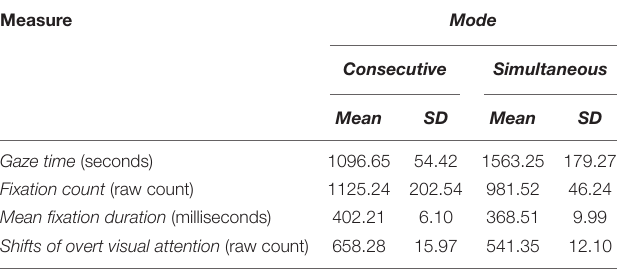
TABLE 1 | Summary descriptive statistics for eye tracking measures between modes.